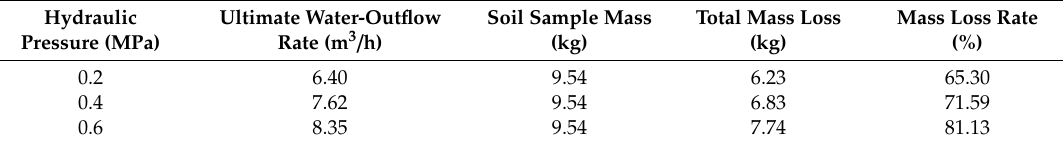
Table 8. Variation of monitoring objects’ characteristic value with hydraulic pressure ( P w